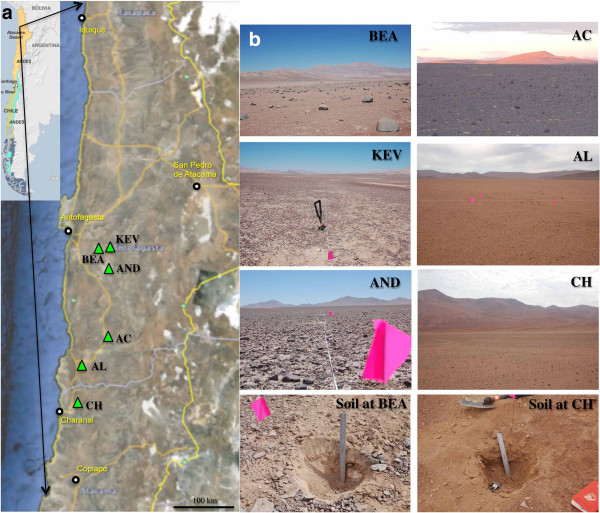
Sampling site locations. (a) Relief map of northern Atacama Desert, Chile, with key field locations marked by green triangles; (b) photos of Kevin Garden (KEV), Bea Hill (BEA), Andrew Garden (AND), Aguas Calientes (AC), Altamira (AL), and Chañaral (CH) sampling locations.